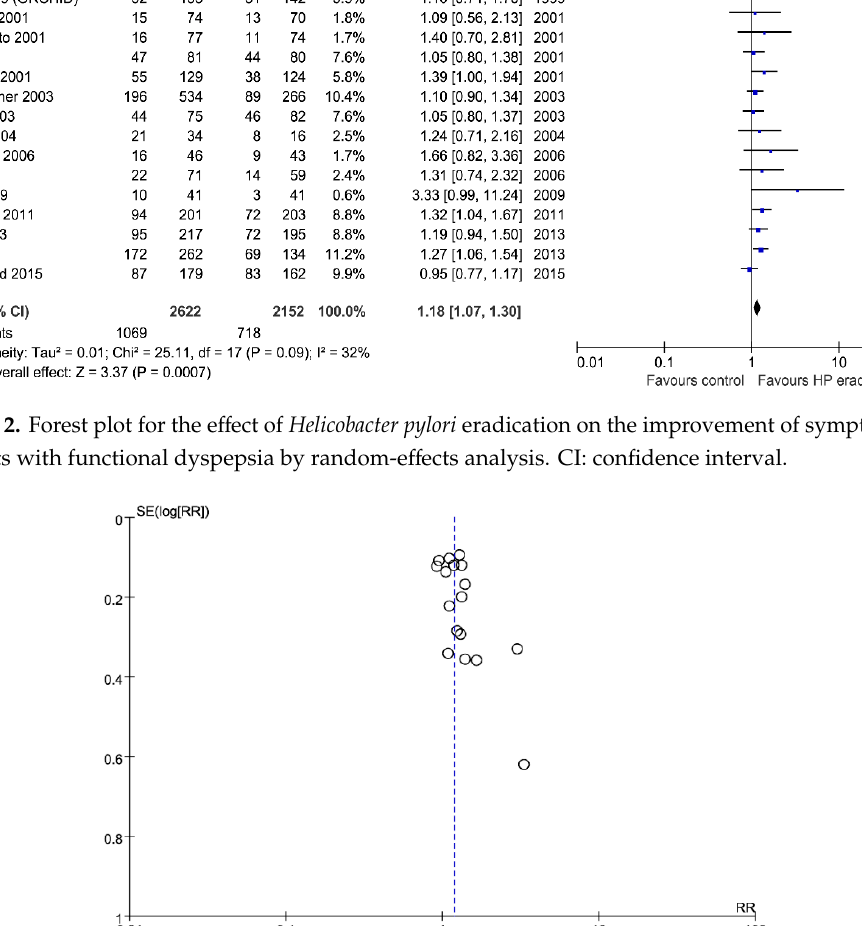
Figure 3. Funnel plot of included studies for potential publication bias.